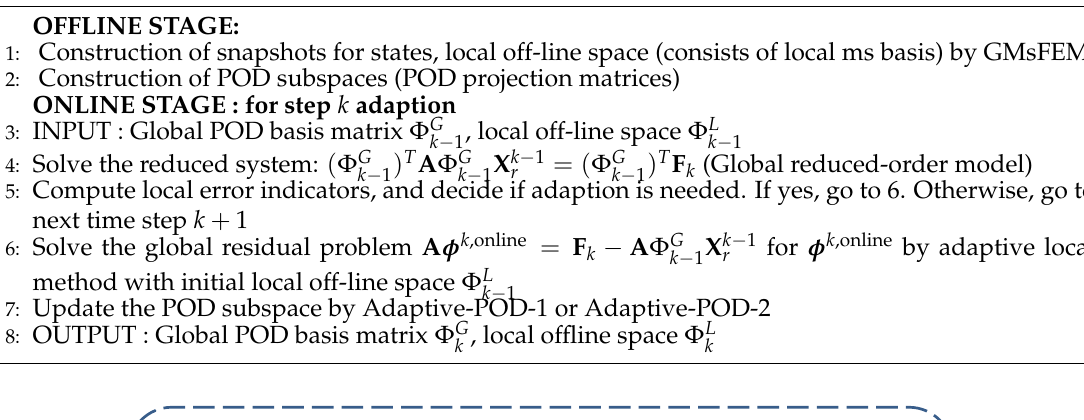
Algorithm 1 Adaptive Local-Global POD Model Order Reduction Method